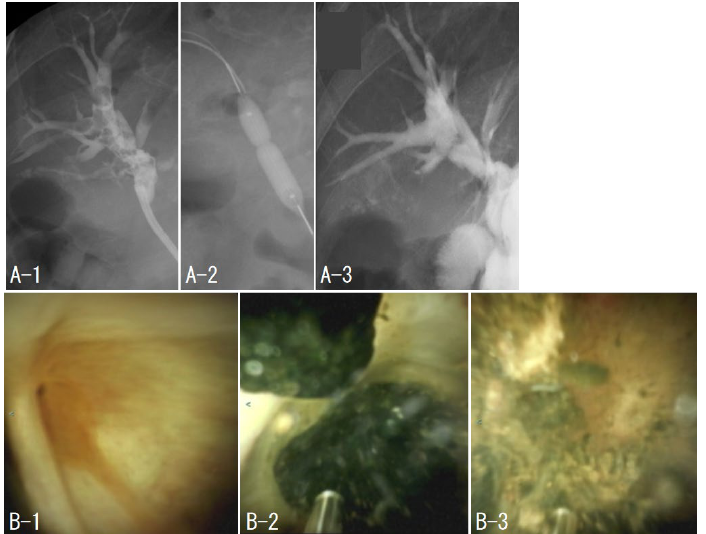
Figure 1. Case 1. The beginning of the right anterior columnar canal was narrowed ( B-1 ), and stones filled the upstream of the stenosis ( A-1 ). Balloon dilation of the stenosis was performed ( A-2 ). The stone was removed by electrohydraulic shockwave lithotripsy under peroral cholangioscopy ( B-2 , B-3 ), and cholangiography was performed to confirm the absence of residual stones ( A-3 ). 2.4. Case 2: Treatment with a Metal Stent to Expand Stenosis in a Patient after Right Hepatectomy The patient had undergone a right hepatectomy for hepatocellular carcinoma. Post- operatively, the left intrahepatic bile duct became stenosed and stones formed upstream of the stenosis. After four sessions of treatment, including EHL under POCS, the stone was almost completely removed. However, the stenosis remained and was difficult to di- late with a plastic stent; hence, a self-expandable metal stent (BONASTENT ® M-Intraduc- tal, MEDICO’S HIRATA Inc., Osaka, Japan) was placed. When the stent was removed one month later, the stenosis had expanded (Figure 2).